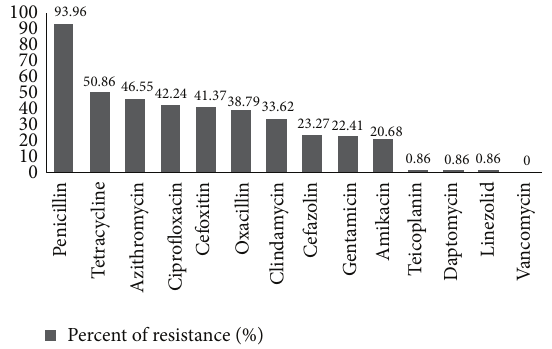
Figure 3: The frequency percent of antibiotic resistance of S. aureus isolated from pemphigus